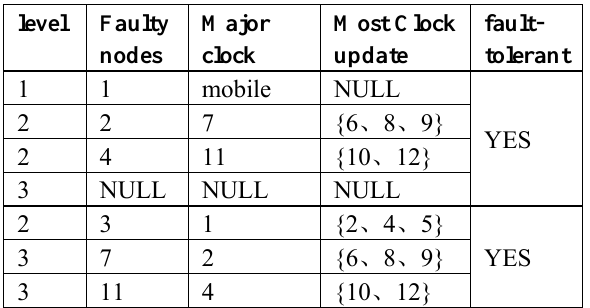
Table1. The faulty nodes and